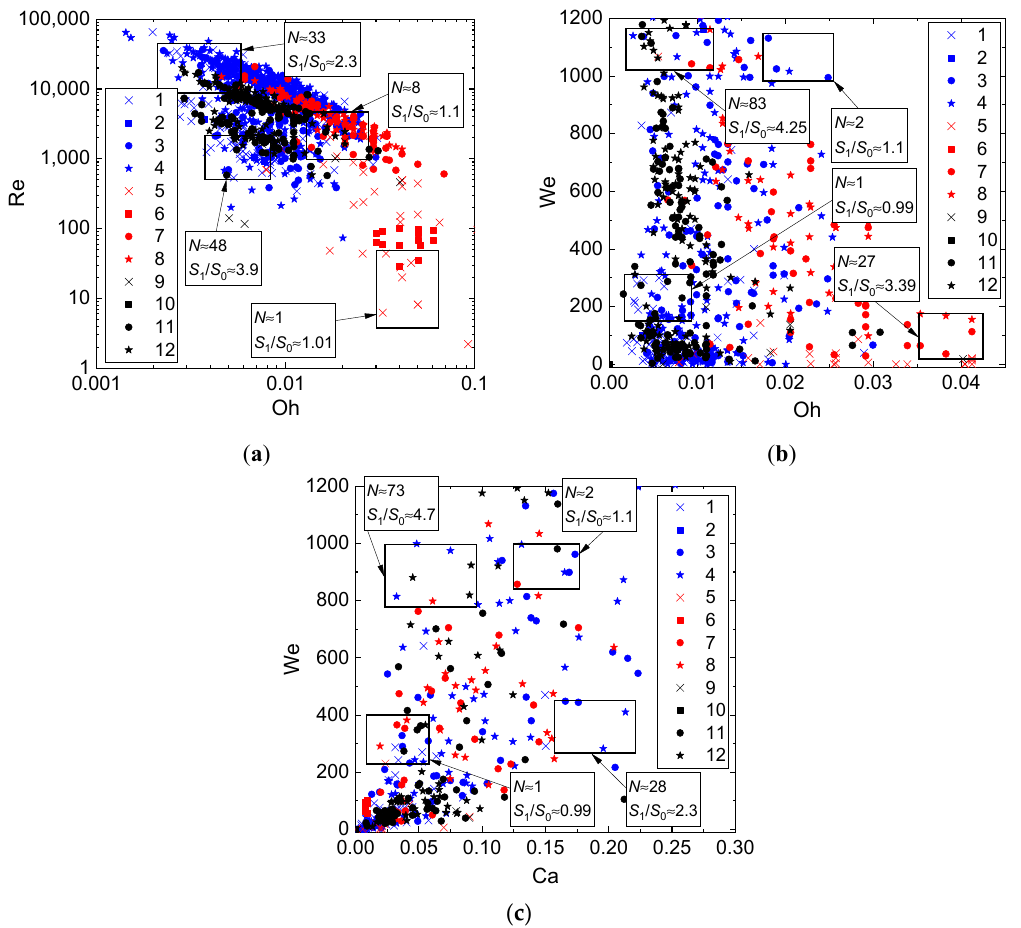
Figure 10. Interaction regime maps (( a )—Re = f (Oh); ( b )—We = f (Oh); ( c )—We = f (Ca)) considering inertia, friction, surface tension, and viscosity for three water slurries under study: water at 20 °C (1—coalescence, 2—bounce, 3—separation, 4—disruption); water at 80 °C (5—coalescence, 6—bounce, 7—separation, 8—disruption); graphite slurry (9—coalescence, 10—bounce, 11—separation, 12—disruption).